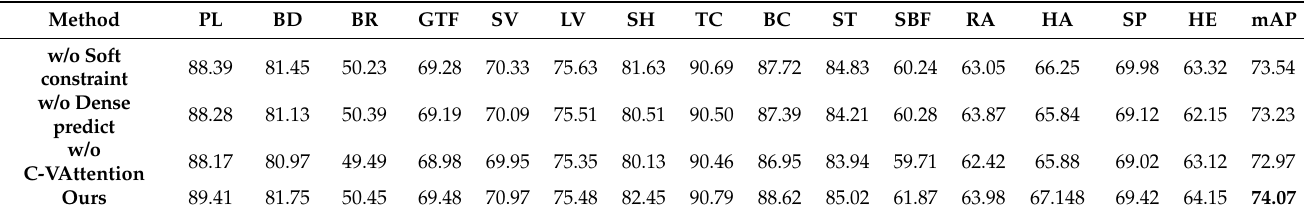
Table 4. Results of the ablation experimental on the full DOTA dataset.